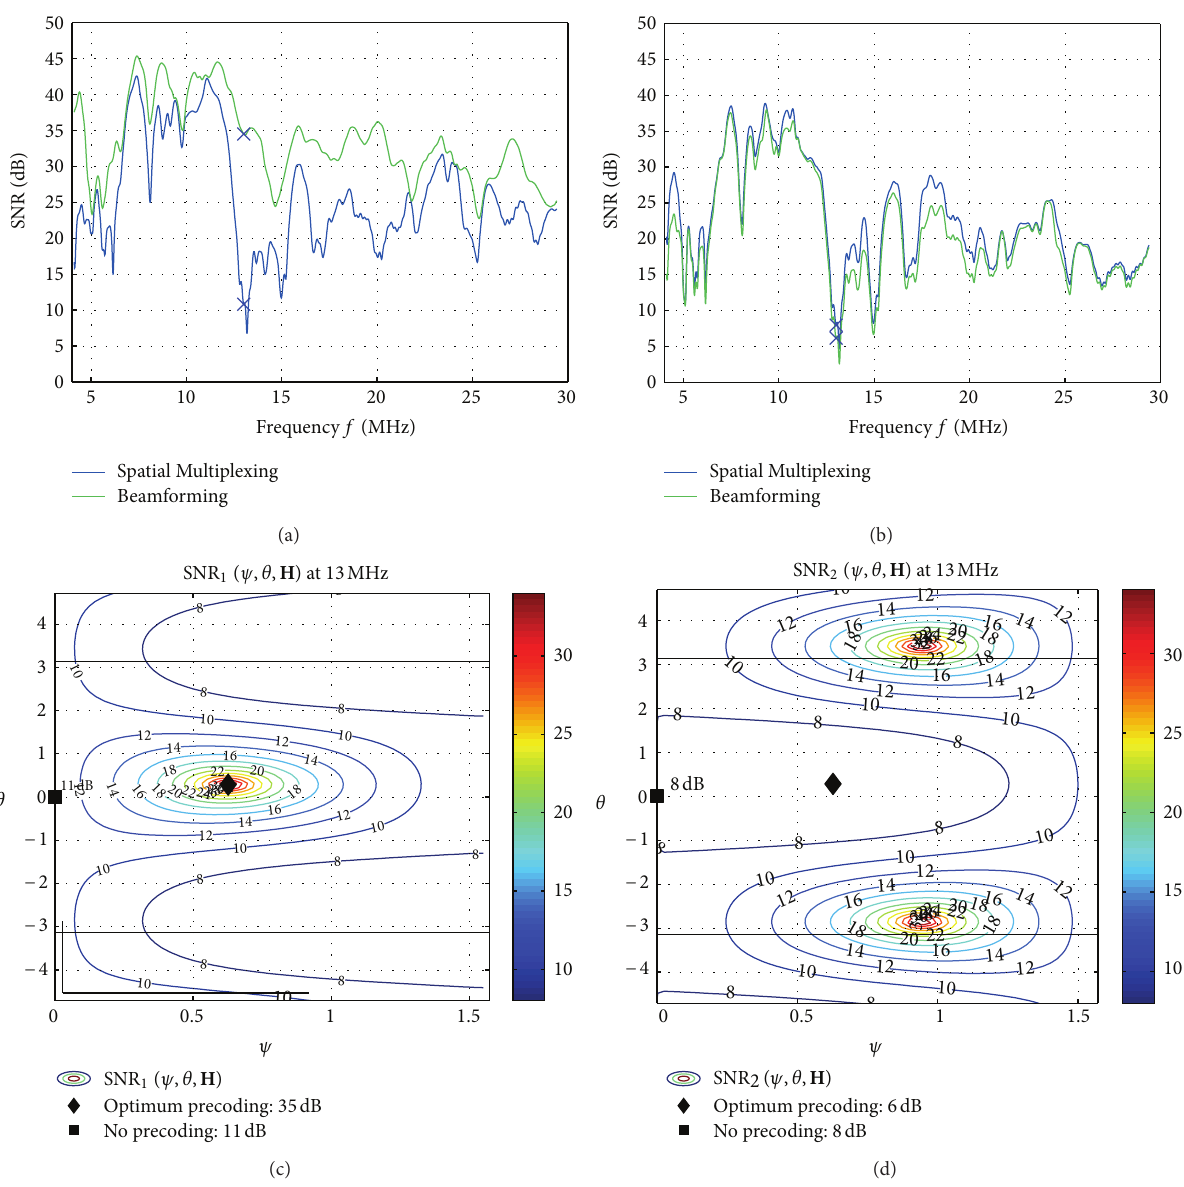
Figure 7: Influence of precoding on the SNR: SNR of the first (a) and second (b) streams with and without precoding, transmit power to noise power of 𝜌 = 65 dB, 40dB average channel attenuation; SNR depending on the precoding matrix at 13 MHz of the first (c) and second (d)